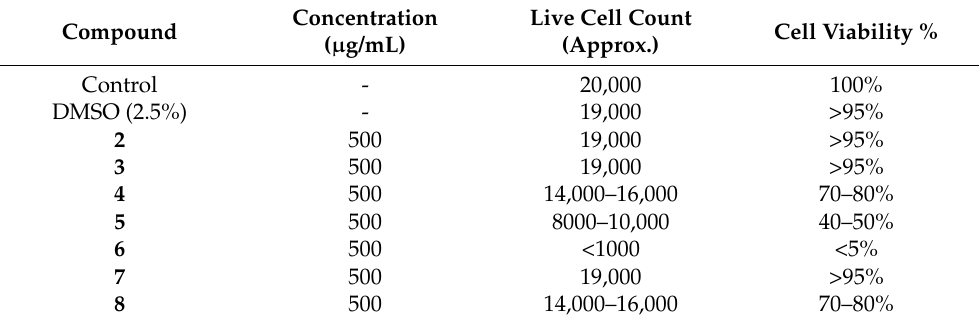
Table 1. Determination of percentage of cell viability after administration of synthesized com- pounds in the trypan blue dye exclusion test.